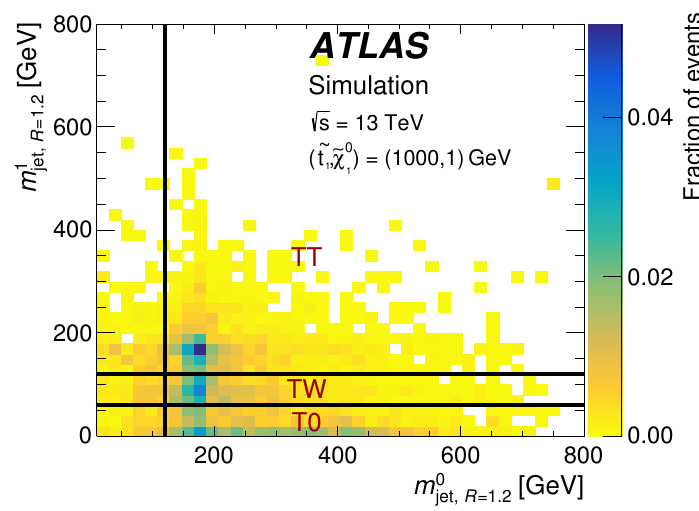
Figure 3. Illustration of signal-region categories (TT, TW, and T0) based on the R = 1 : 2 reclus- tered top-candidate masses for simulated direct top-squark pair production with ( m ~ (1000 ; 1) GeV after the loose preselection requirement described in the text. The black lines repre- sent the requirements on the reclustered jet